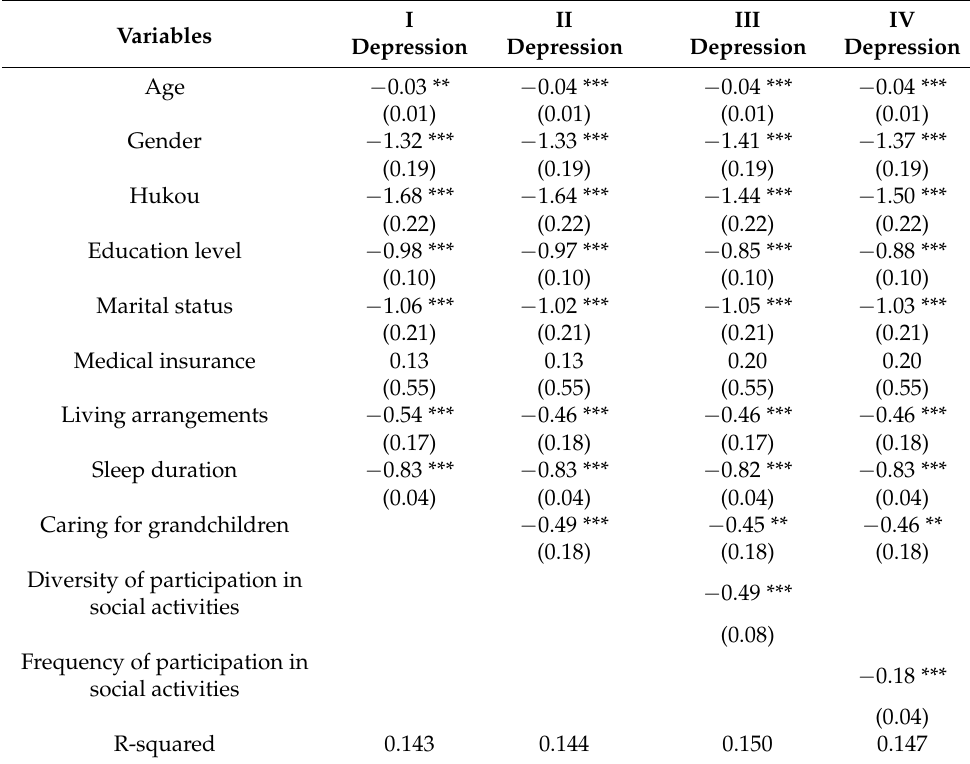
Table 3. Impact of caring for grandchildren on depression of the